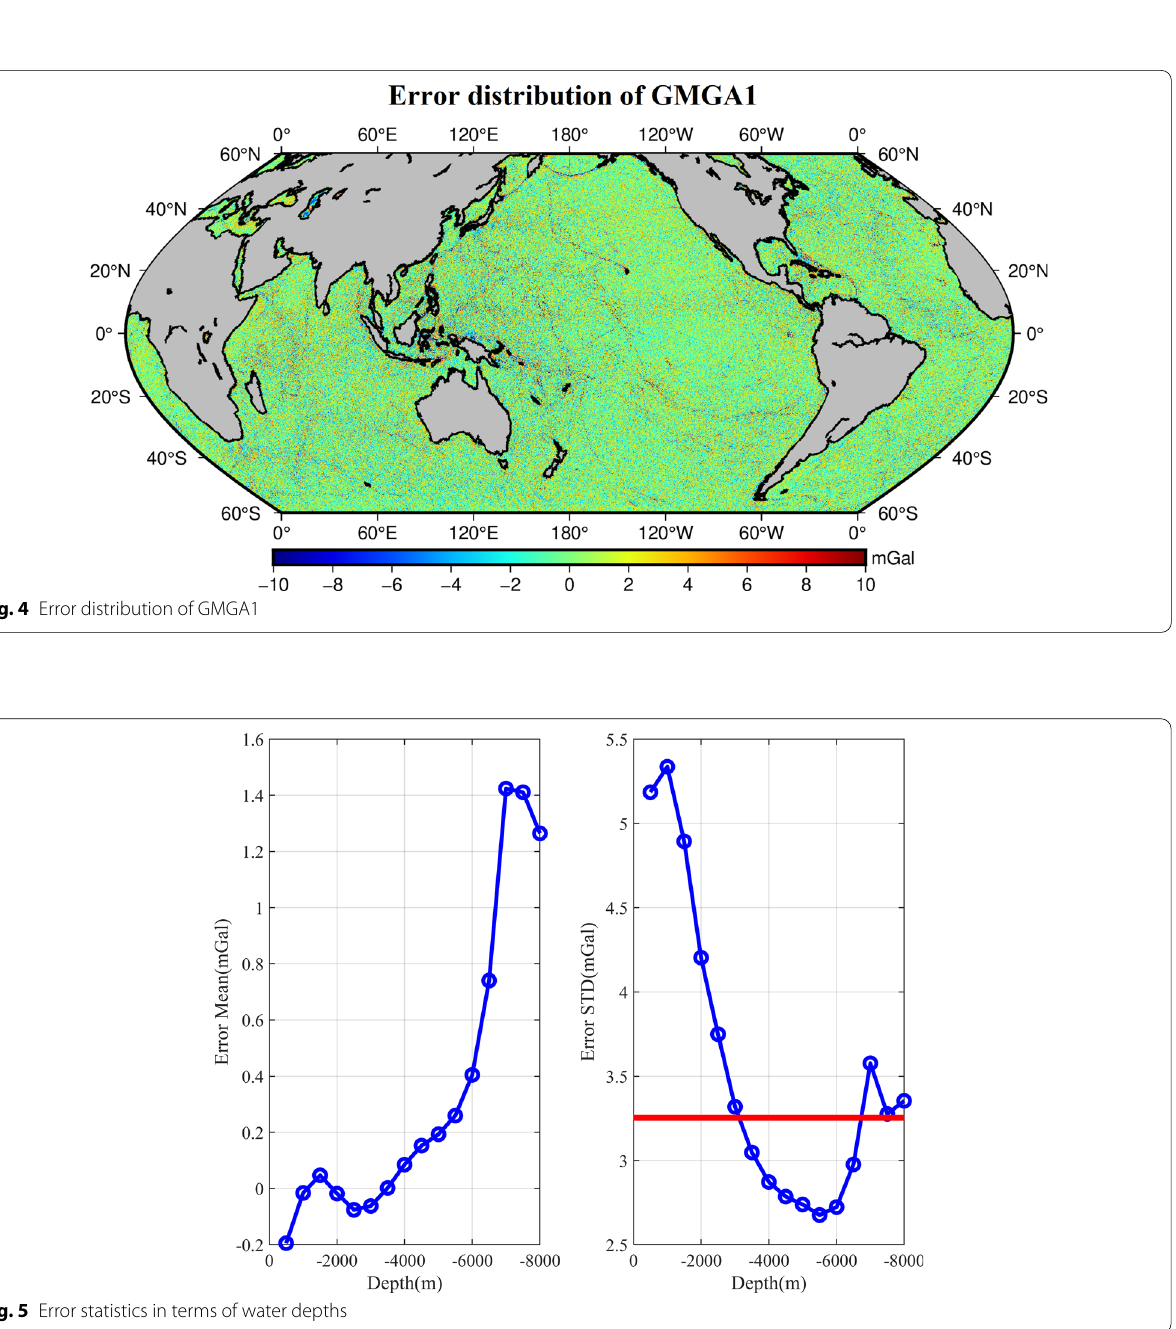
Fig. 5 Error statistics in terms of water